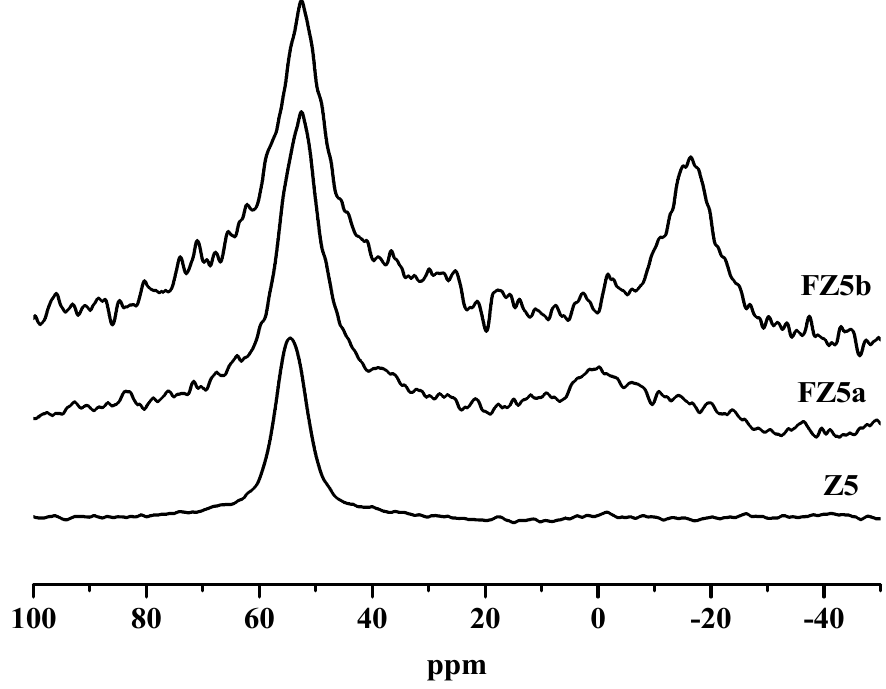
Figure 6. 27 Al MAS NMR of pristine ZSM-5 zeolite and fluorinated zeolites. Upon fluorination treatment, a shift of resonance from 55 ppm to 54 ppm is observed for the fluorinated FZ5a and FZ5b, reflecting the interaction/perturbation of fluoride with the framework Al sites. At low level fluorination, the resonance at 0 ppm appears, indicating the parallel dealumination of framework Al sites to non-framework Al species. However, the high fluorination level leads to the reduction of the resonance at 0 ppm and a significant resonance at − 16 ppm, the latter of which is assigned to the AlF 3 phases [28]. Therefore, the fluorination of siliceous ZSM-5 zeolites leads to various alterations to the framework sites as the function of fluorination level: perturbation of the environment of framework Al sites due to the Al-F complexation, dealumination to the octa-coordinated non-framework Al species and formation of the AlF 3 phase. The alterations, in particular the latter two different modes of dislodge of framework Al sites, intervene the sequential conditions. Upon the low fluorination level, the generated non-framework Al sites are re- 65 ◦ C for 30 min. It is interesting to note that such a decelerating effect is overcome by the extension of alkaline treatment duration to 60 min as reflected by the appearance of signifi- cant mesoporosity in the BJH profile of AT(65,60)-FZ5a. The similar delayed